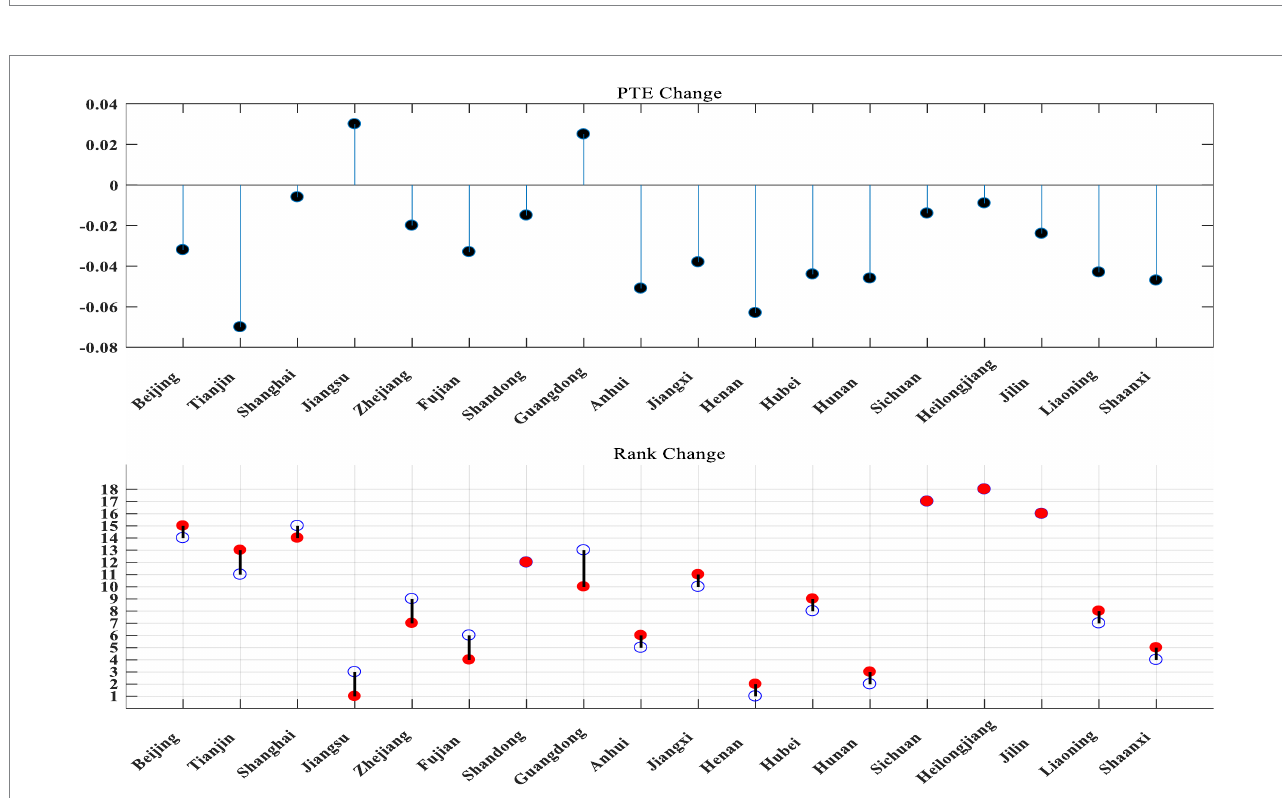
FIGURE 5 Changes in the three stages of PTE for technology and finance in strategic emerging industries.